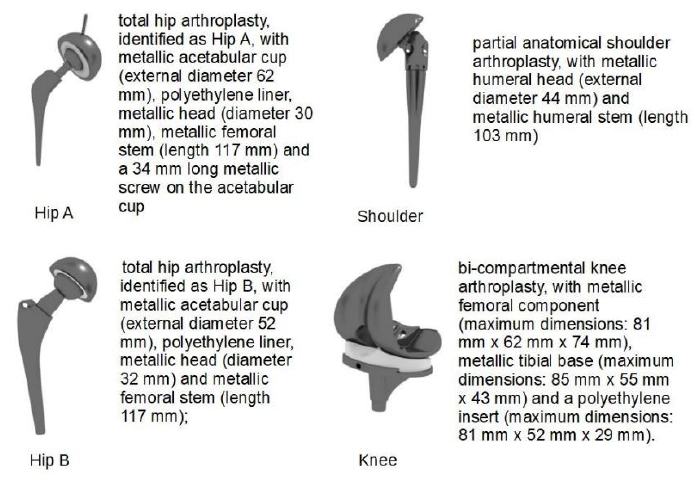
Figure 1. Prosthesis models used in the in silico heating evaluation.